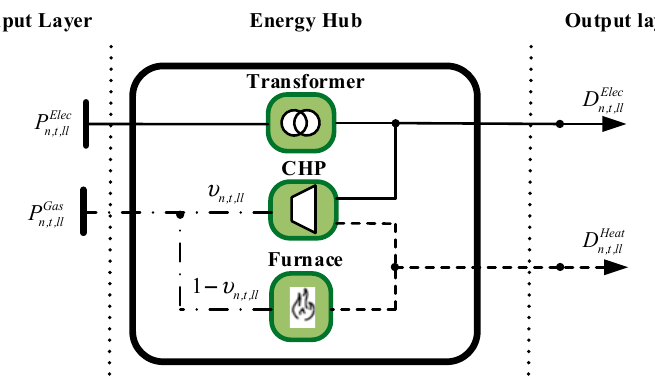
Figure 2. Structure of the proposed energy